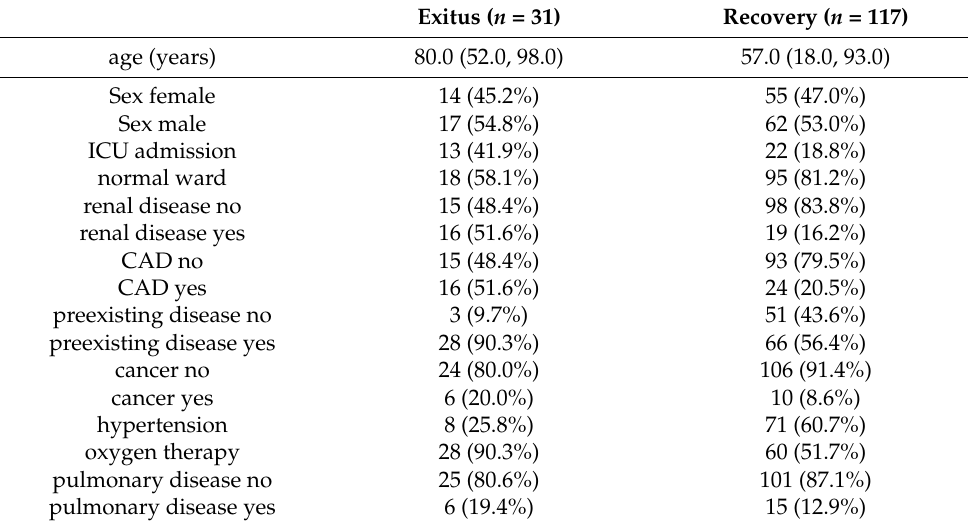
Table 1. Baseline characteristics of COVID-19 patients.